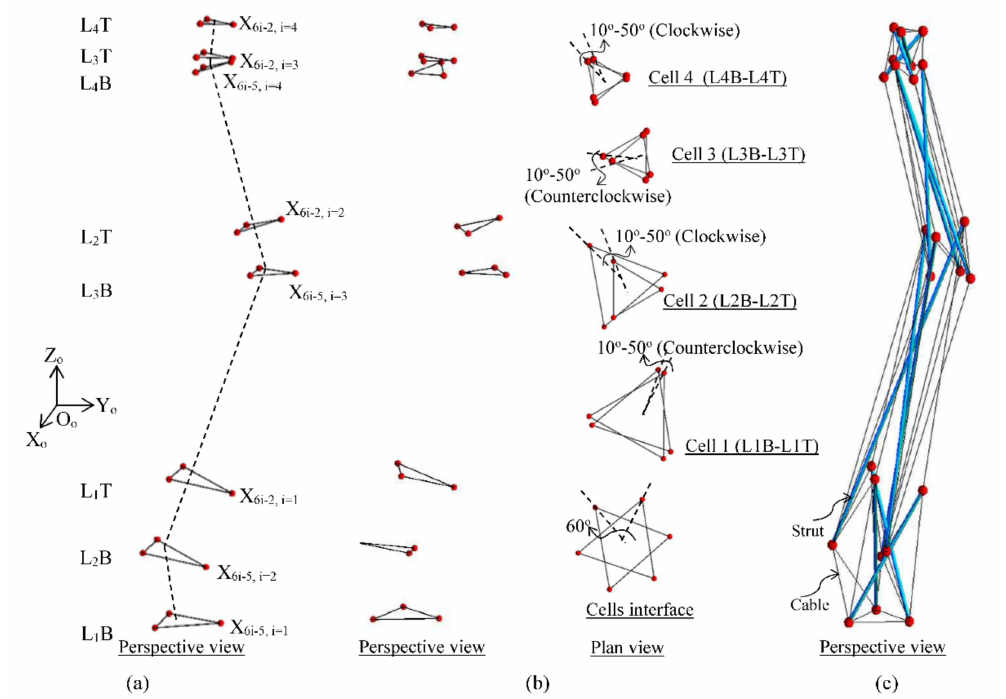
Figure 7. Assemblage of a spine biotensegrity model ( a ) fitting of triangular surfaces perpendicular to the established curvature line, ( b ) twisting of cells shown in elevation and plan view, ( c ) incorporation of struts and cables according to the element connectivity